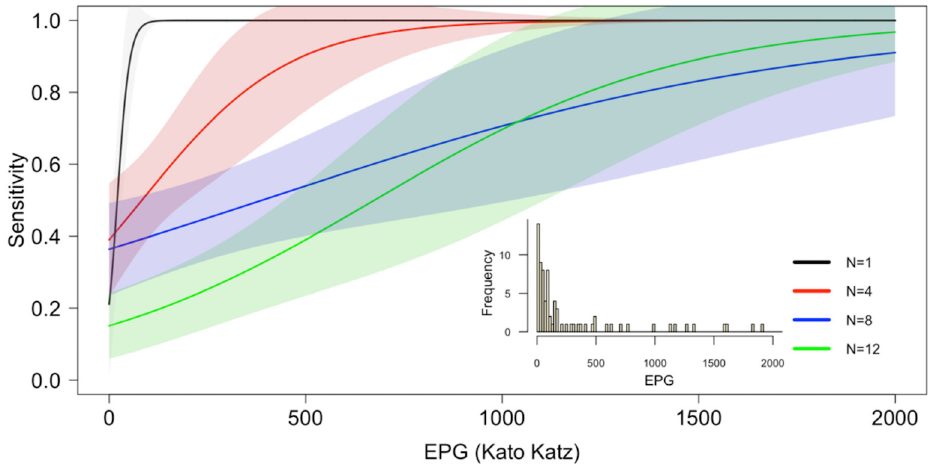
Fig 1. Modeled estimation of the sensitivity of the urine pooling strategy. Positive urine sample confirmed by quadruplicate Kato-Katz thick smears and single POC-CCA urine cassette test were combined with three (n = 4), seven (n = 8), or 11 (n = 12) negative urine samples. A logistic regression was used to model sensitivity of the pooled urine samples (n = 4, 8, and 12) as a function of the infection intensity (EPG) of the one infected urine. The distribution of S . mansoni infections used in this model included light, moderate, and heavy intensity infections (figure